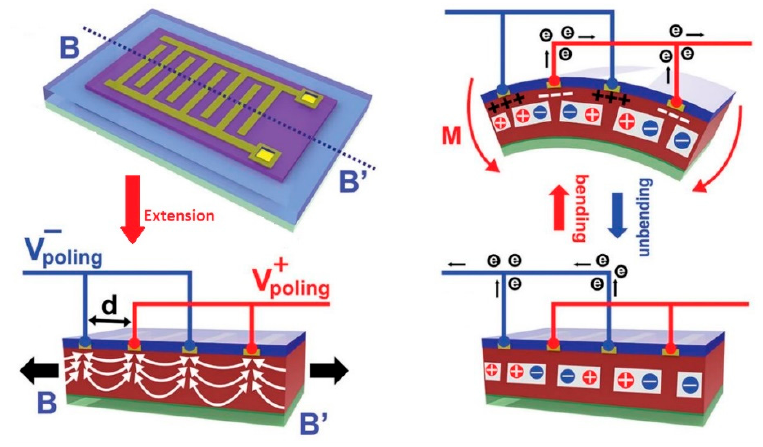
Figure 7. Schematic Diagram of working of flexible Piezoelectric sensors [140].